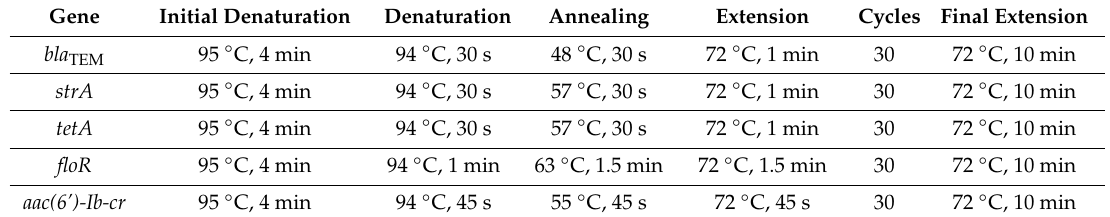
Table 2. PCR reaction